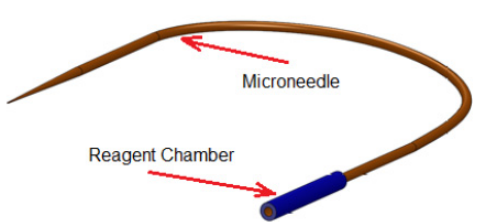
Figure 4. Schematic of the microneedle (OD = 90 µ m, ID = 20 µ m, length = 80 mm) connected to the reagent chamber (ID = 0.5 (mm), OD = 1 (mm), length = 25 (mm)).